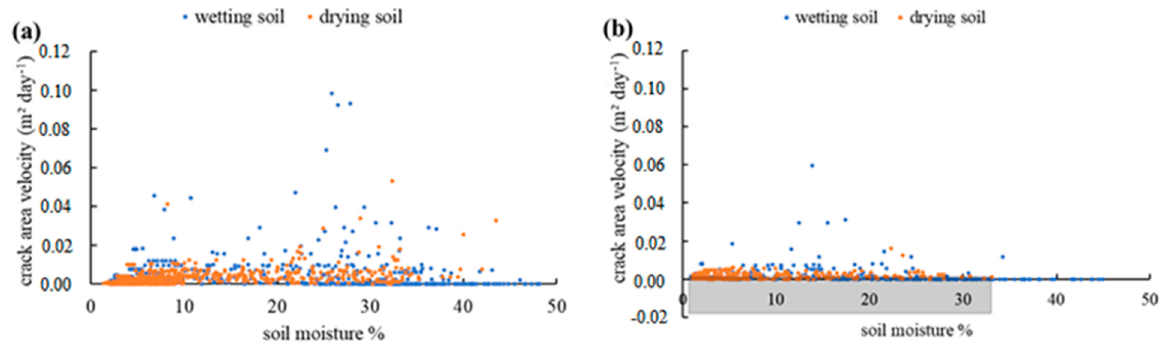
Figure 14. Velocity of crack opening/closure (m 2 /day) in the ( a ) CL and ( b ) SCL